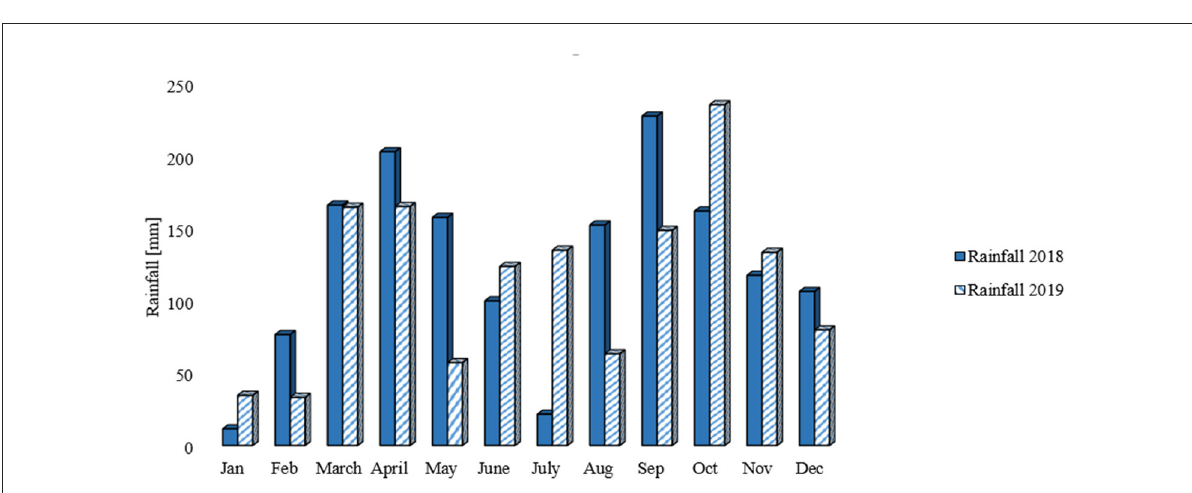
FIGURE2 Rainfall distribution of Kamwenge district for the period of two years in 2018 and 2019. Source Ekyaligonza et al. (2022).